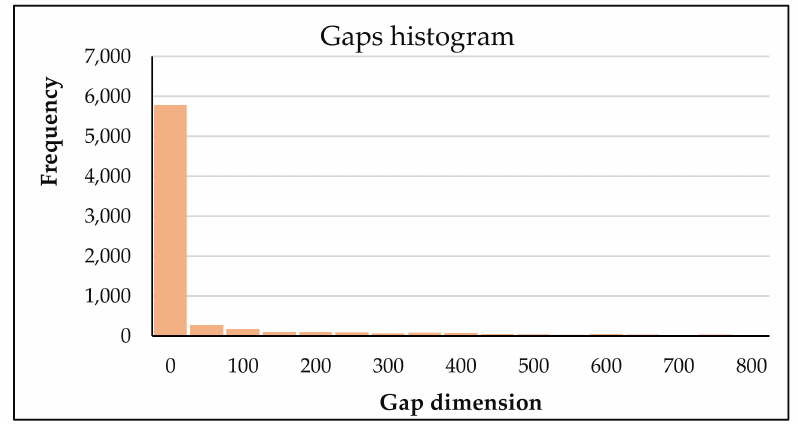
Figure 4. Histogram of interday gaps in the consumption series.